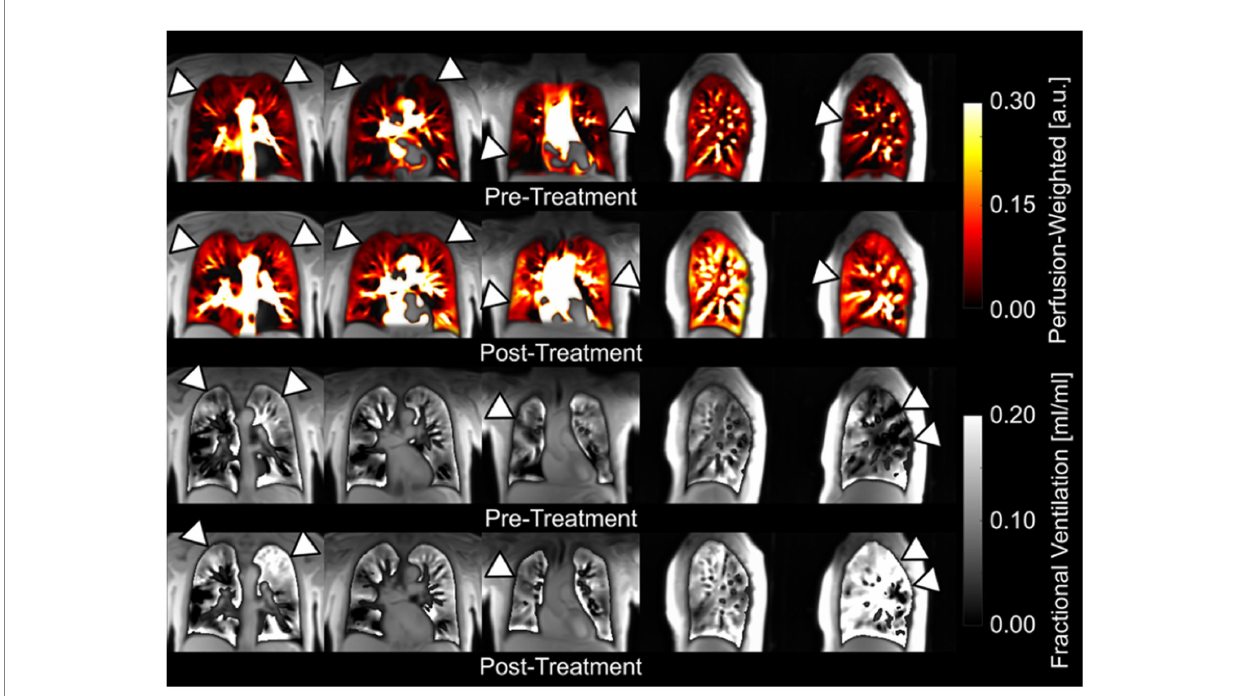
FIGURE 5 Coronal and sagittal fractional ventilation and perfusion-weighted maps of a patient with chronic obstructive pulmonary disease obtained with a free- breathing, contrast agent-free method (PREFUL) pre-and post-14 days of inhaler treatment (264). Please note the visible improvements (arrowheads) in perfusion and ventilation after treatment and the possibility for a pixelwise ventilation-perfusion assessment. Adapted with permission from